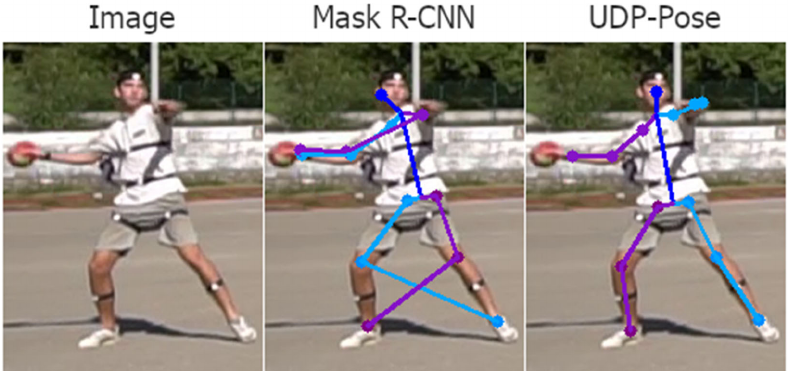
Figure 22. Examples of detection after training on the 227 images of the RI ‐ HJS dataset. The right side of the player is coloured purple while the left side of the person is coloured blue. Untrained models made a mistake and switched the players’ sides, shown in Figure 19. After training, UDP ‐ Pose successfully detected keypoints on the correct sides, while Mask R ‐ CNN did not manage to detect all keypoint sides correctly.